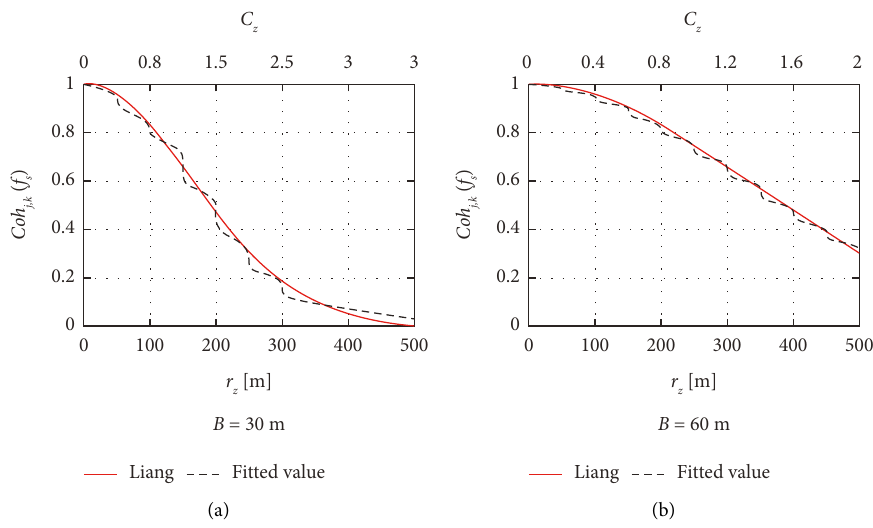
Figure 5: Vertical correlation at vortex shedding frequency for across-wind forces: D/B � 2.